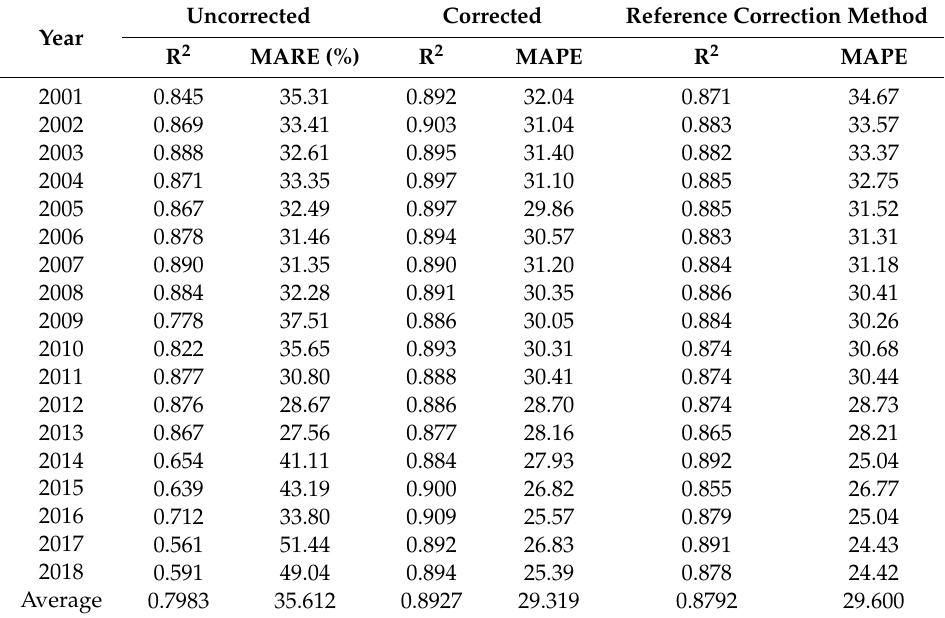
Table 8. Model fitting precision values between TNL and EPC using quadratic polynomial model in provincial